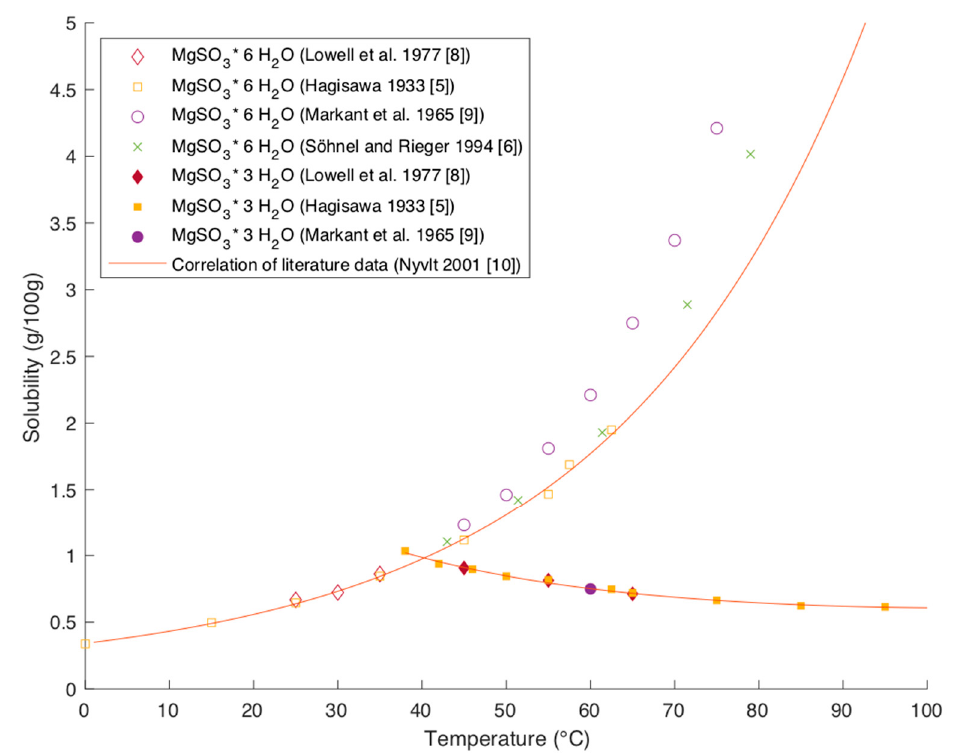
Figure 2. Solubility of MgSO 3 in Water [5,6,8–10].